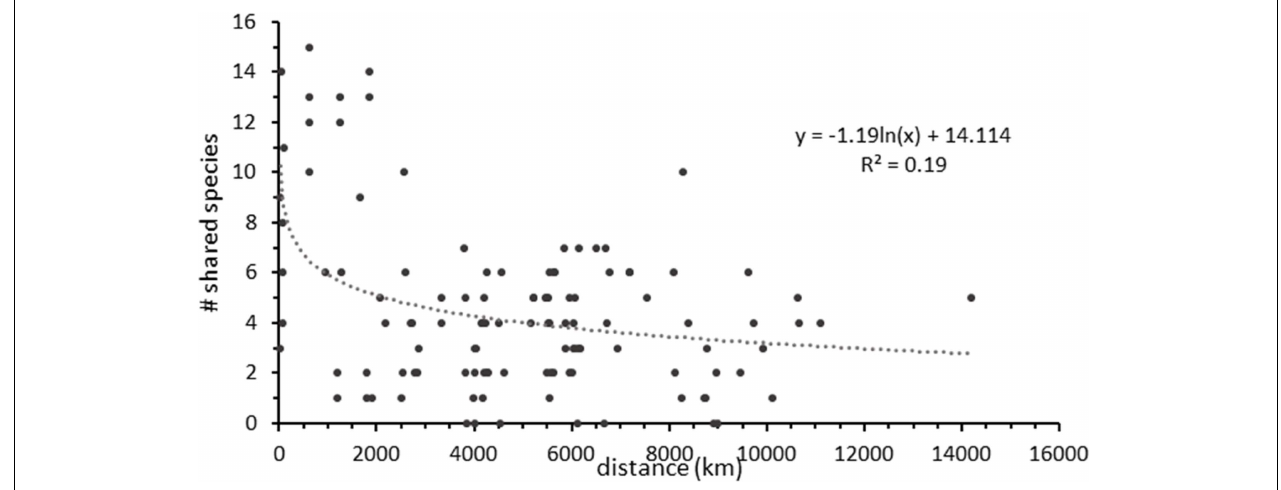
FIGURE 9 | The number of shared scavenger taxa between all possible combinations of baited camera station pairs as a function of distance (km) between the